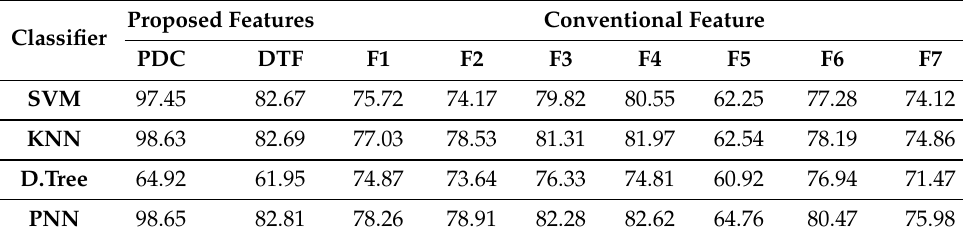
Table 5. Comparison of the proposed method with the conventional feature extraction techniques in terms of classification accuracy